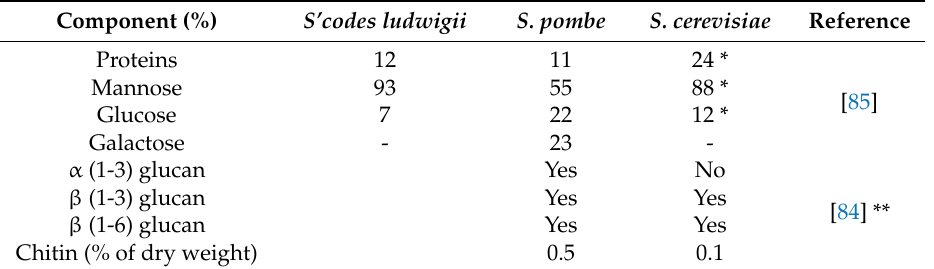
Table 2. Composition of cell walls of Saccharomycodes ludwigii , Schizosaccharomyces pombe and Saccharomyces cerevisiae